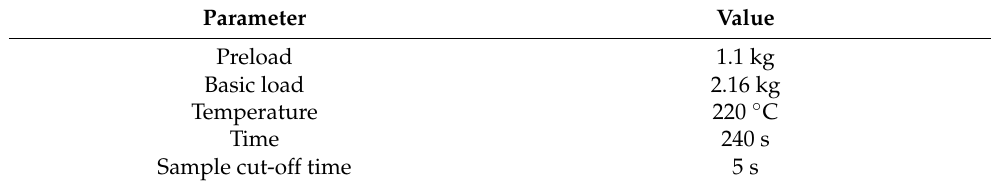
Table 3. Parameters of the MFR